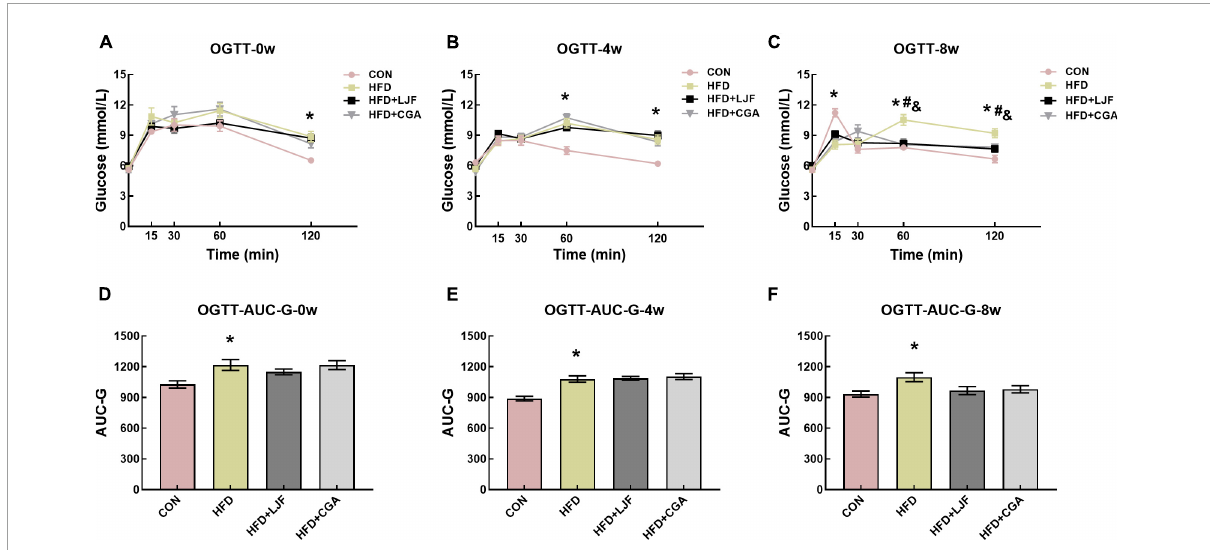
FIGURE2 Lonicerae Japonicae Flos and CGA protect against HFD-induced IR and glucose homeostasis disorder in prediabetes rats. (A–C) Blood glucose during the oral glucose tolerance test (OGTT) was measured at the indicated time points after administration of 2 g/kg glucose to rats, following consumption of PBS, LJF or CGA for 0, 4, or 8 weeks ( n = 8 per group). (D–F) The area under the curve of glucose (AUC-G). Dates are presented as bar graphs with means ± SEM. * P < 0.05, HFD group vs. CON group; # P < 0.05, HFD+LJF vs. HFD group; & P < 0.05, HFD+CGA vs. HFD